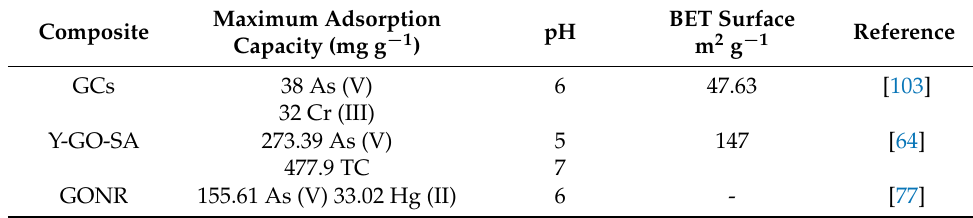
Table 4. Multicomponent adsorption on composites of